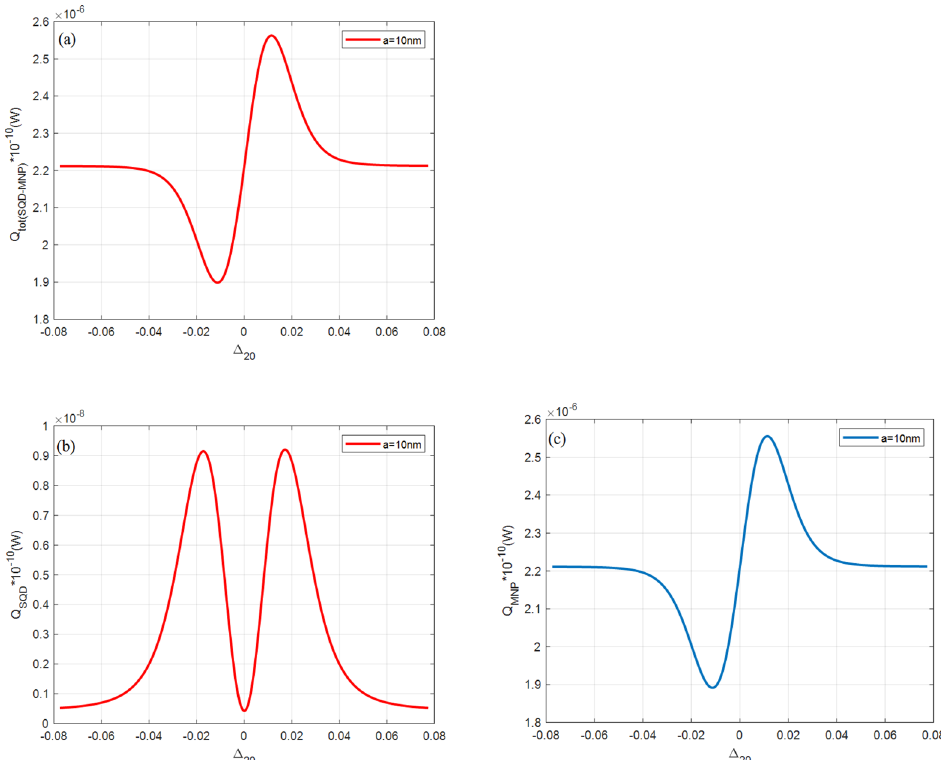
Figure 9. ( a ) The total ( Q tot ) , ( b ) single QD ( Q SQD ), and ( c ) MNP ( Q MNP ) absorption rates from SQD- MNP hybrid system at R = 20nm and a = 10nm for a single QD. Other parameters are (cid:31) 0 02 = 0.09meV , � 0